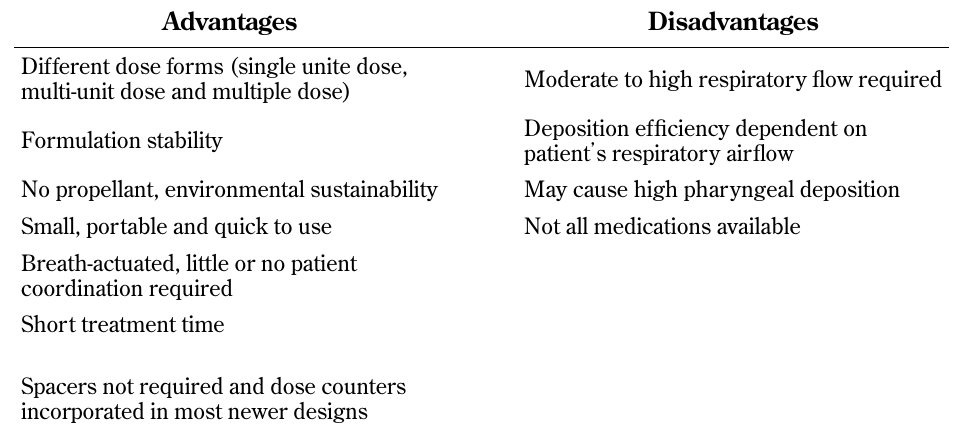
Table 1 Summary of advantages and disadvantages of dry powder